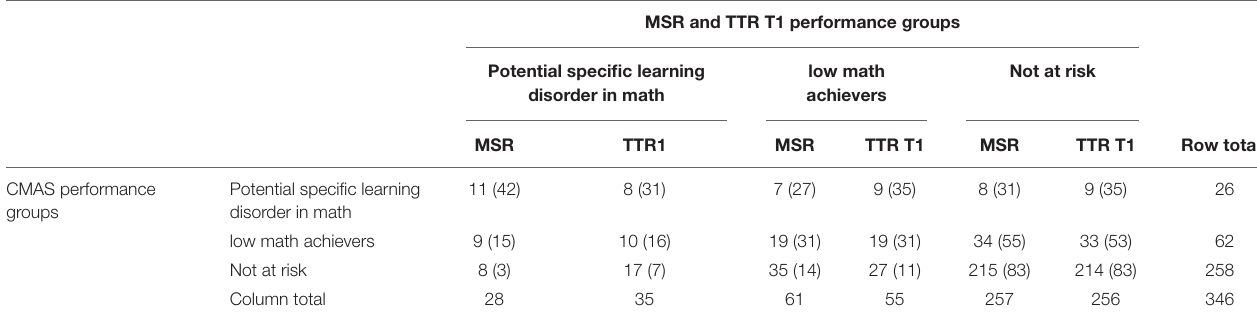
TABLE 2 | Cross table for CMAS performance groups with MSR and TTR T1 performance